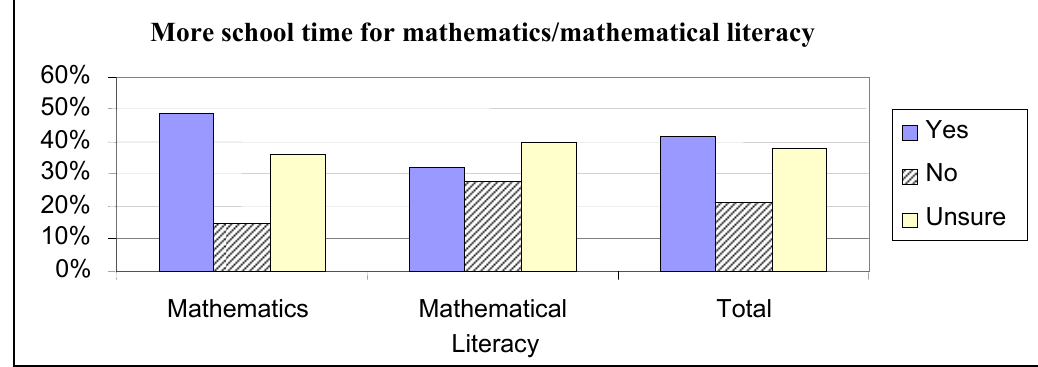
Figure 3 : Views of learners on school time for mathematics/mathematical